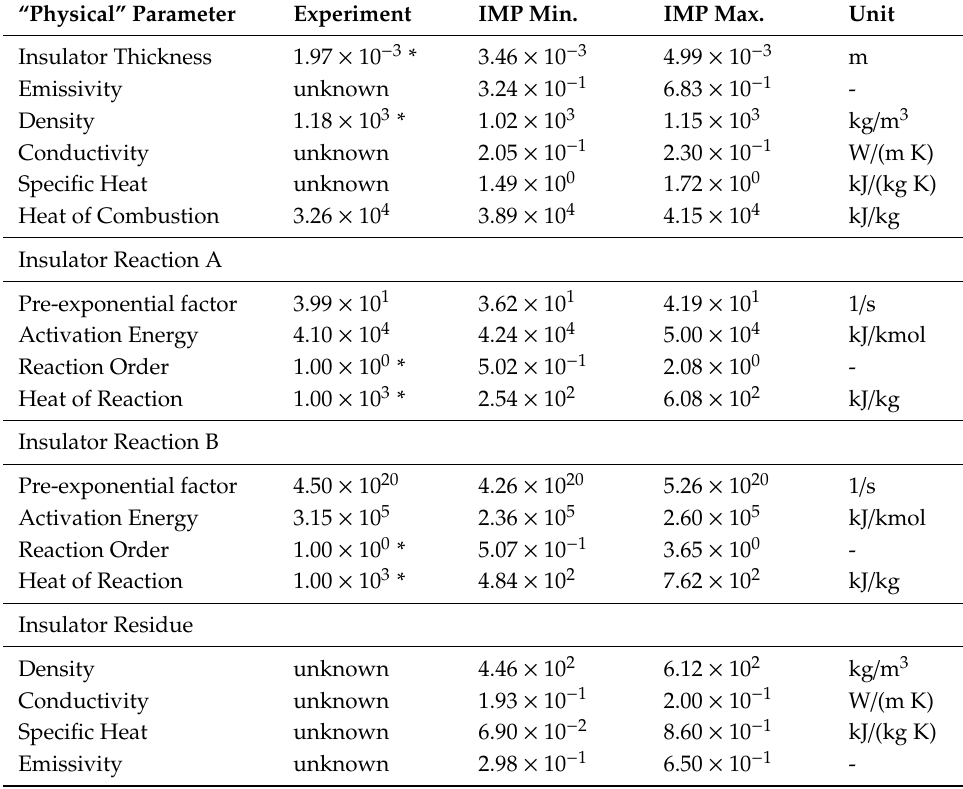
Table A1. Overview of the optimisation parameters of the IMP runs for the insulator. Data from the experiment is provided, if available. Layer thickness has been projected from a circular to a rectangular cross section to account for the layered representation in FDS. From the best parameter sets, over all IMP runs, the minimum (IMP Min.) and maximum (IMP Max.) values are provided. The parameter sequence is the same as for the ribbon plots, simply skipping parameters that are not used. (Note: values labelled with “*” are guessed and / or FDS